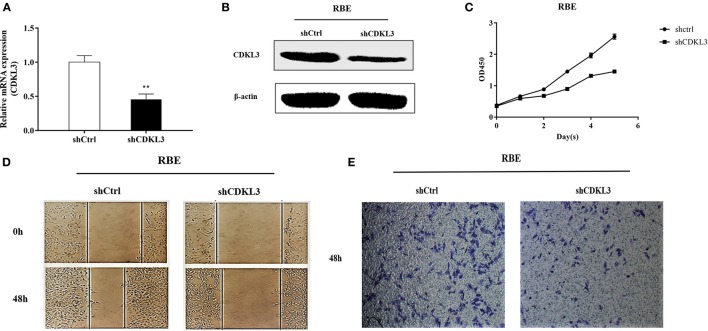
Knockdown of CDKL3 inhibits proliferation, migration and invasion of RBE cell. Representative RT-PCR (A) and Western blot analysis (B) of CDKL3 knockdown by lentiviral shRNA against CDKL3 are shown. Knockdown of CDKL3 greatly inhibited the proliferation (C), migration (D), and invasion (E) of RBE cells. Values represent mean ± SD. *P < 0.05, **P < 0.01, as compared with shCtrl.